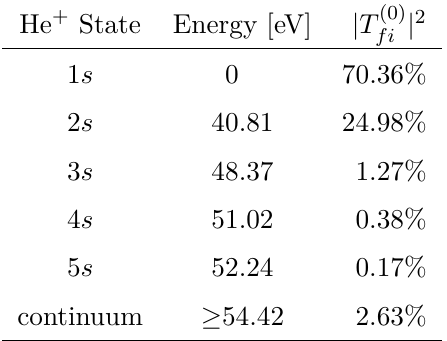
Figure 1 . Fraction of decays to helium energy levels 1 s (ground state), 2 s , 3 s , 4 s + 5 s of the orbital electron, as well emission of the orbital electron (continuum) as a function of the β -decay electron energy below the endpoint.